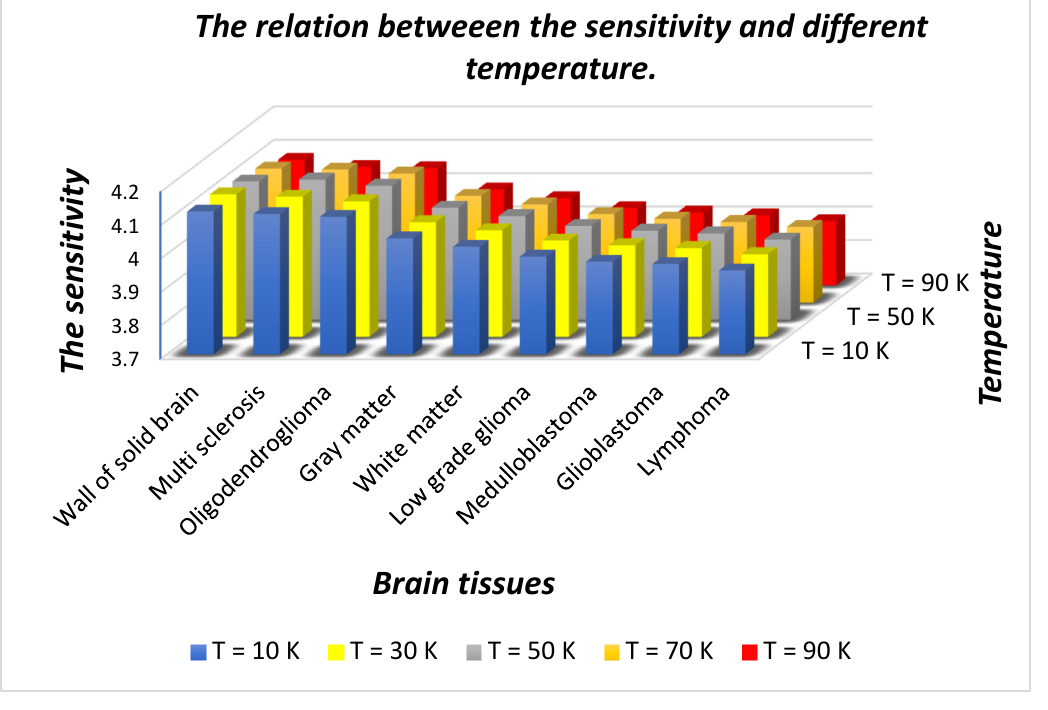
Figure 6. The 3D bar graph showing temperature dependent sensitivity of the proposed 1D DPhC( AB ) 2 CDC ( AB ) 2 when the cavity is loaded with nine different samples containing brain tissues at d 4 = 15 dd , η = 0.8 and θ = 63 ° corresponding to different values of ambient temperature.